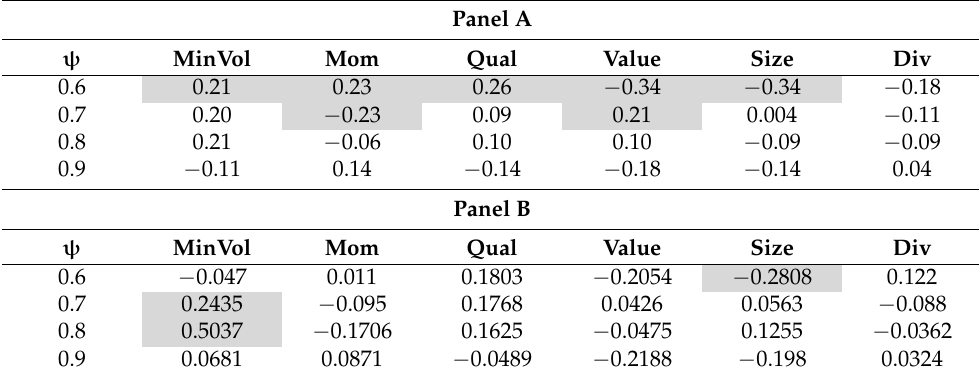
Table 5. Correlation between smart beta and VIX for α = 0. Panel A includes data from January 2014 to May 2019, Panel B from January 2014 to May 2020. Highlighted values are those significantly different from zero—Pearson correlation.